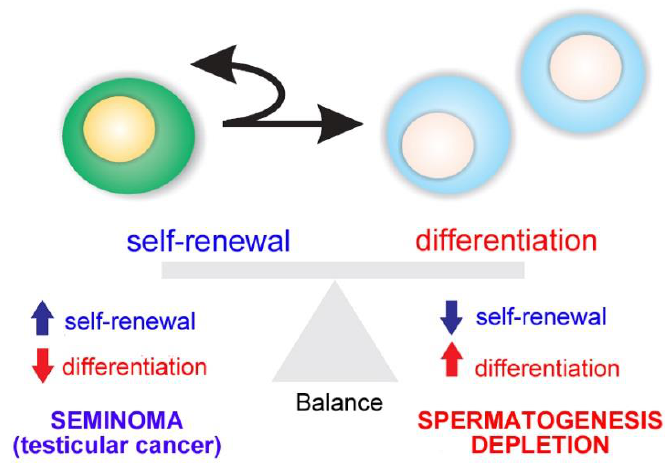
Figure 2. Balance between spermatogonial stem cell (SSC) self-renewal and differentiation. An imbalance results in testicular cancer or depletion of spermatogenesis.